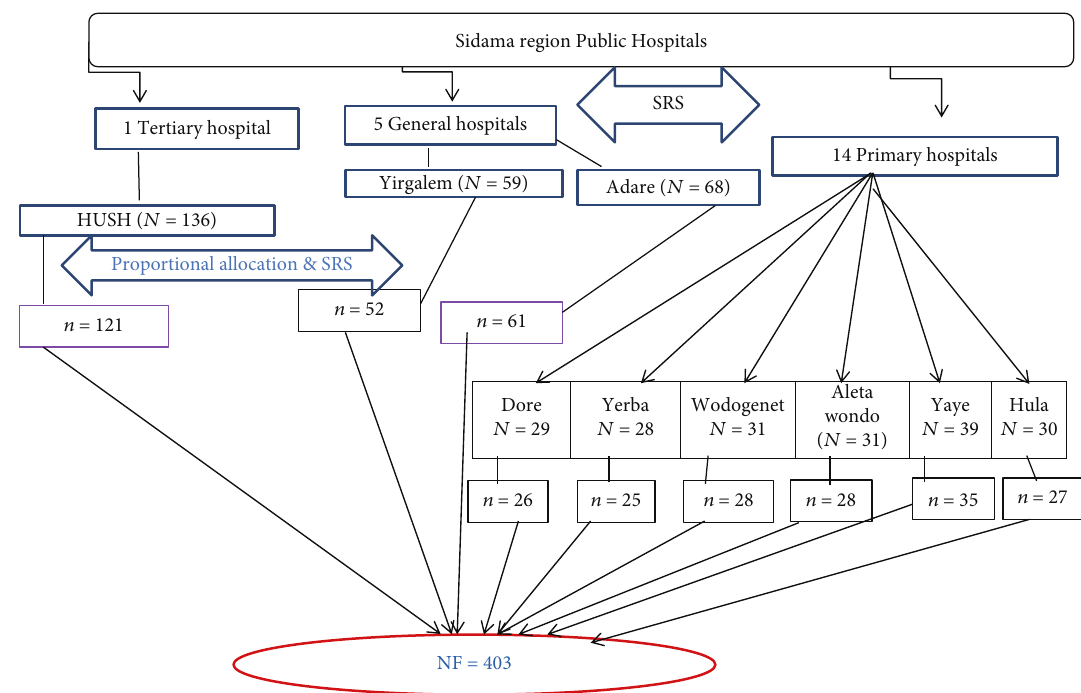
Figure 1: Schematic diagram of the sampling procedure for obstetric care providers of Sidama regional state public